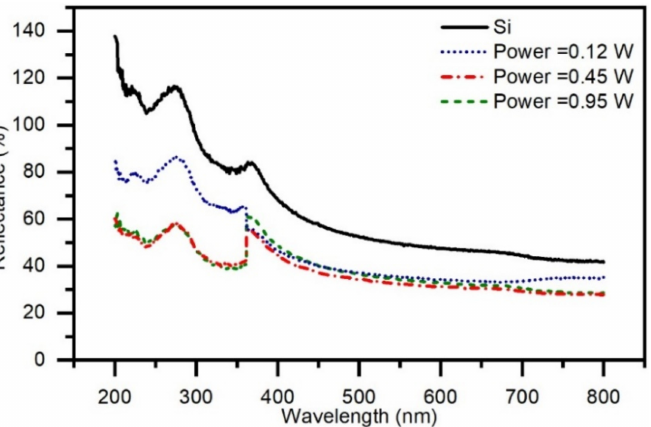
Figure 7. Reflectance spectra of silicon irradiated by a femtosecond laser at different laser powers.